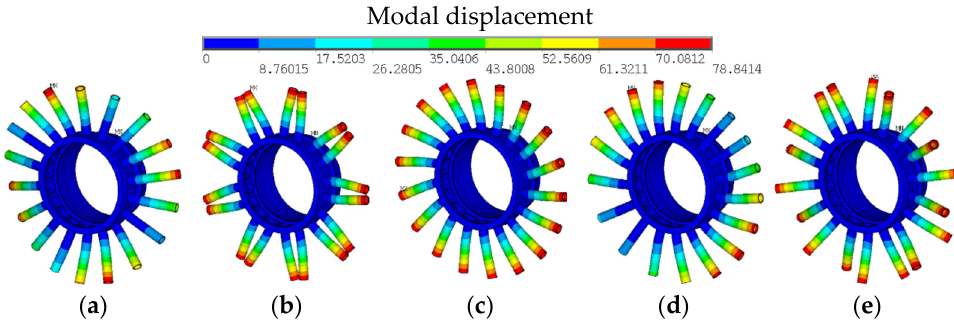
Figure 11. Typical modal shapes of the first bending mode family: ( a ) First mode; ( b ) Second mode; ( c ) First mode; ( d ) Second mode; ( e ) First mode.